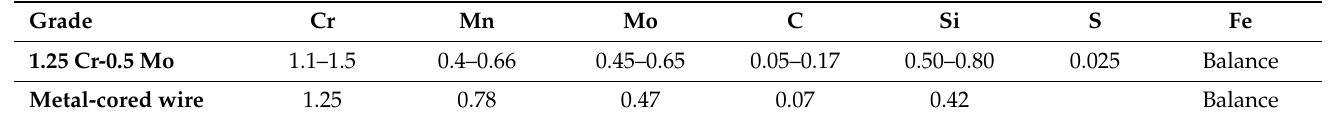
Table 1. Chemical composition of base material and